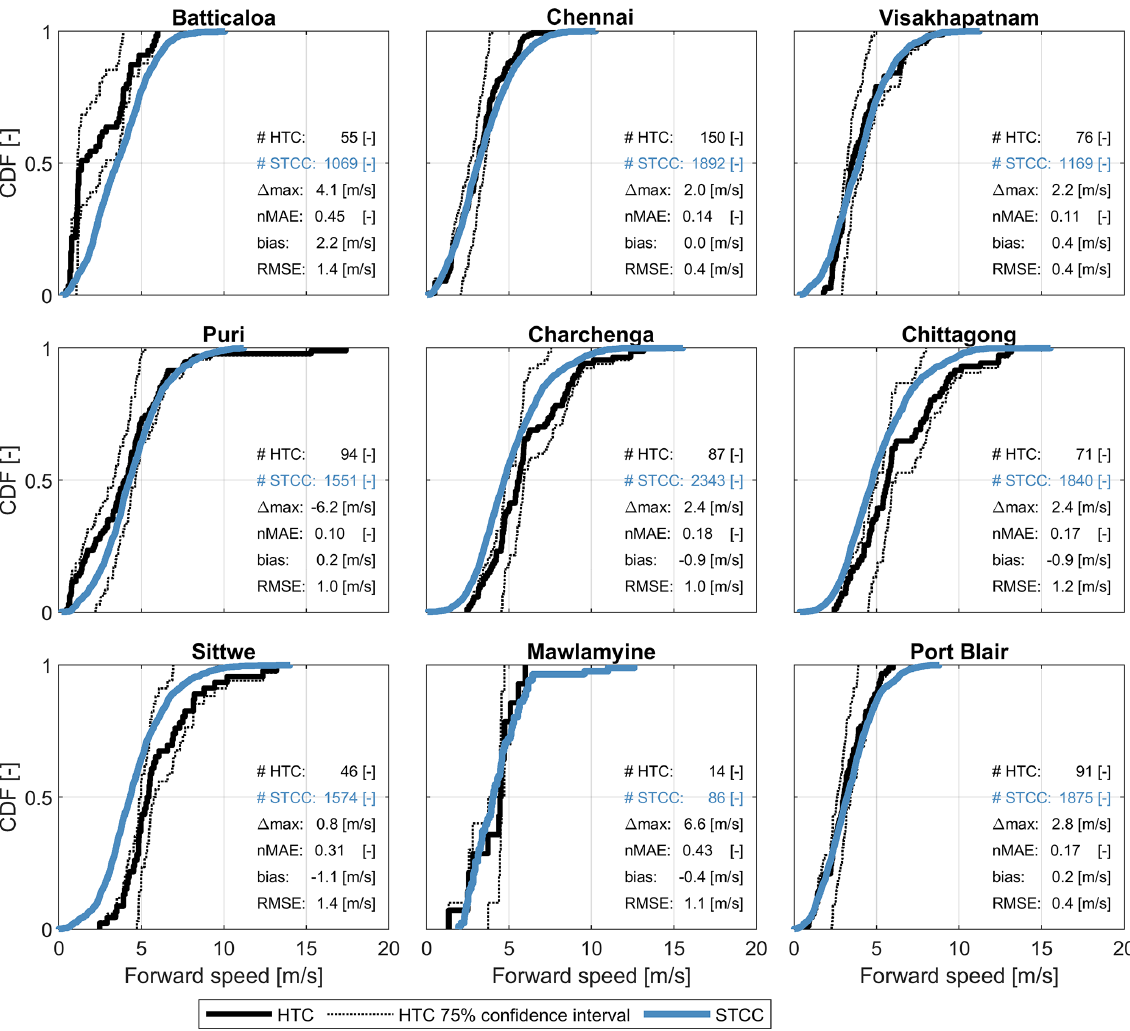
Figure B2. Comparison between CDFs of forward speed for HTCs (black line) with 75% confidence intervals (dashed line) and STCC (blue line) at nine locations along the Bay of Bengal. The functions are estimated based on TCs within a 200km radius of each location. The number of samples (time steps of a TC) within the 200km radius is indicated (#HTC and #STCC), alongside several statistical parameters comparing the HTC and STCC distributions (i.e., absolute difference in maxima ( (cid:49) max), normalized mean absolute error (nMAE), the relative bias of the median value (bias) and the root-mean-square error (RMSE) of the whole CDF. The nine locations are shown in Fig. 1.